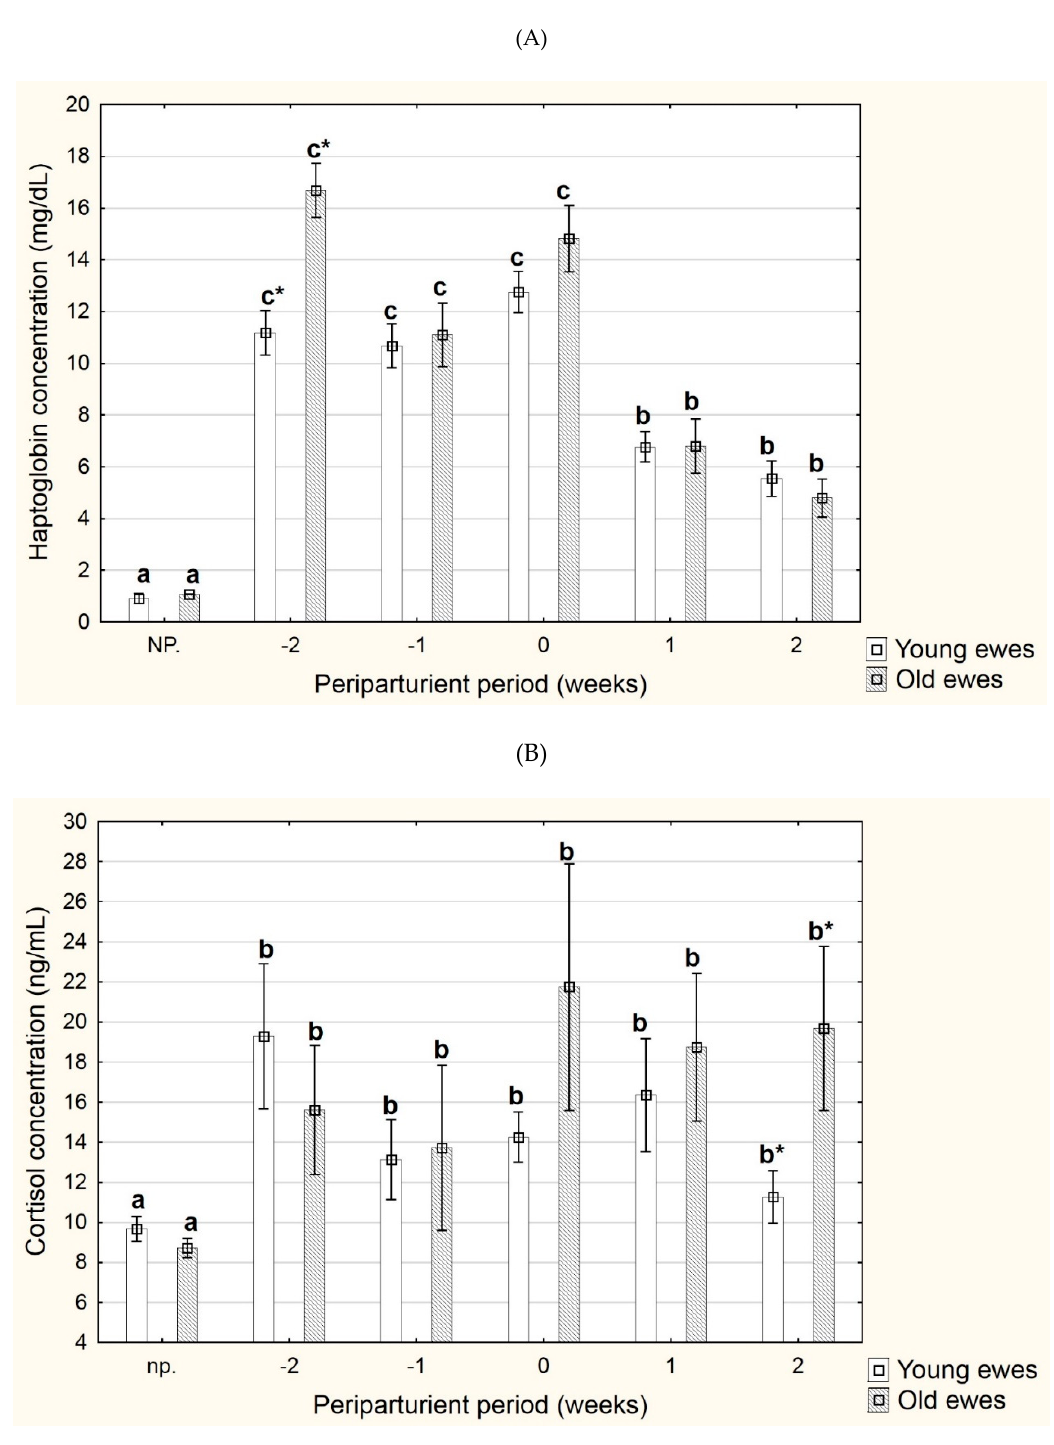
Figure 1 Changes in the concentration of haptoglobin (Hp, mg/dL) ( A ) and cortisol (ng/mL) ( B ) in blood plasma of young and old ewes; Data are expressed as the mean ± standard error (SE); a,b,c indicate that the values obtained at various time points (np., − 2, − 1, 0, 1, or 2) and denoted with different letters are different ( p < 0.05); Means within a group (young/old) denoted with * are signif- icantly different ( p < 0.05). Young ewes were three years of age, and old ewes were seven years of age; ( n = 18); Abbreviations: NP, non-pregnant ewes (2–3 weeks before insemination); − 2, 2 weeks before parturition; − 1, 1 week before parturition; 0, parturition; 1, 1 week after parturition; 2, 2 weeks after parturition. For most haematological parameters, the differences between the periparturient pe- riod and the period before pregnancy were observed (Table 2). The red blood cell (RBC) values were significantly lower throughout the periparturient period compared to the